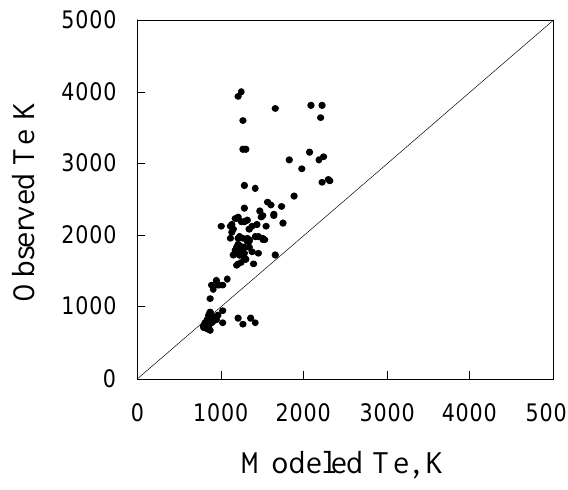
Fig. 3. Scatter plot of observed electron temperature at ∼ 500km against those predicted by the IRI model for Fig.3. Scatter plot of observed electron temperature at ~500km against those predicted by the IRI model for summer.